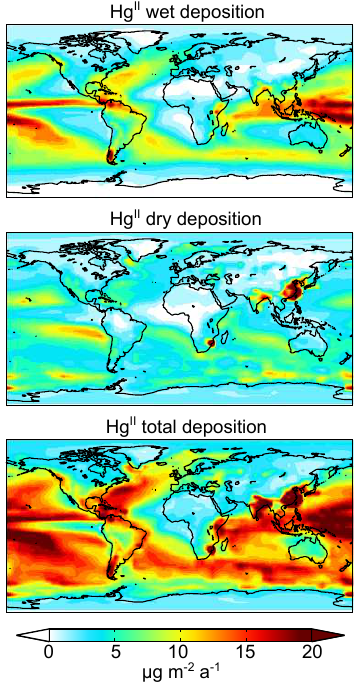
Figure 7. Annual 2009–2011Hg II deposition fluxes in GEOS-